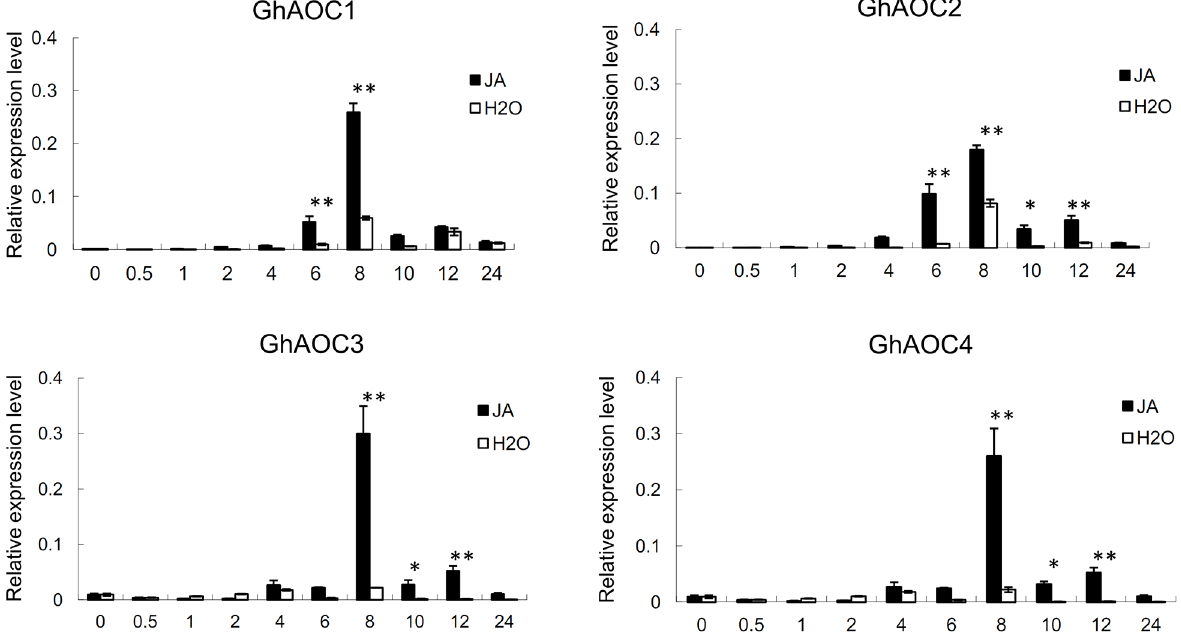
Fig 7. Expression of AOCs following JA treatment. The timepoints after initial JA treatment are shown, and treatment with water was used as a control. Significant differences at the 0.05 and 0.01 probability levels are represented by * and ** , respectively. Error bars indicate ± SD of triplicate experiments. Three biological replicates were used for